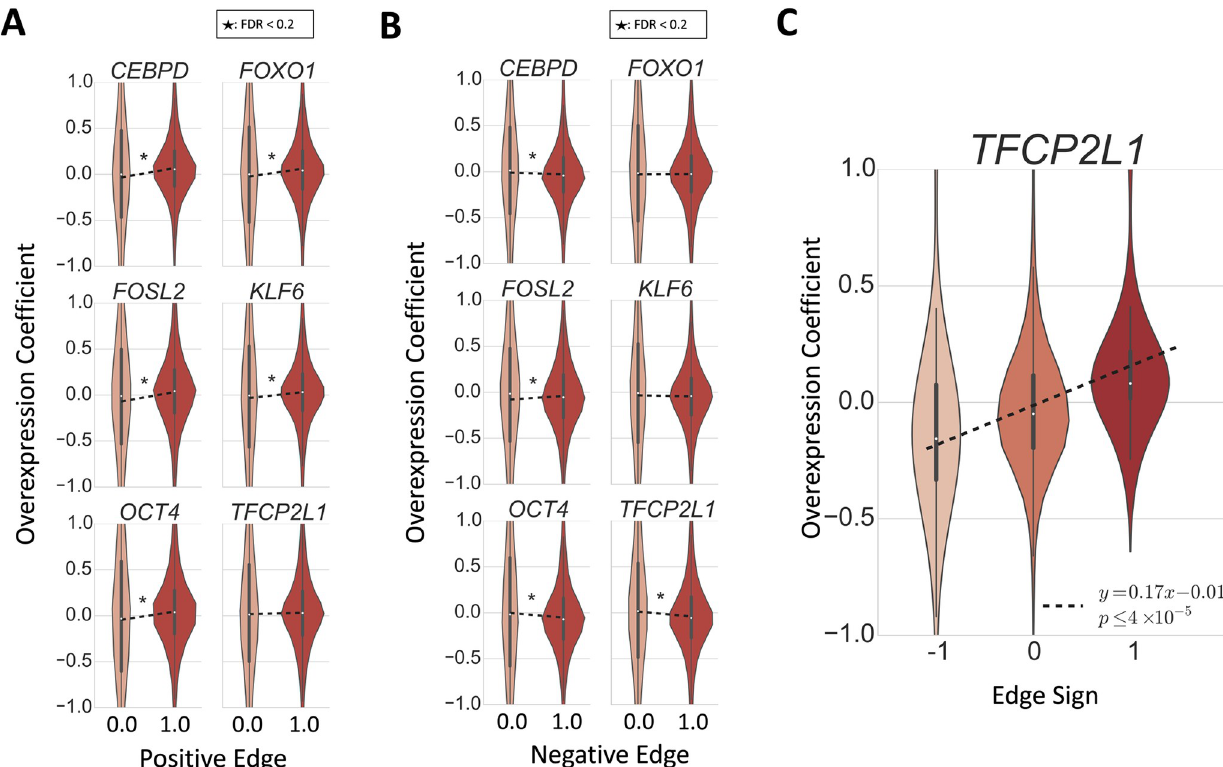
Fig 6. Validation of inferred network on overexpression data. A-B) Regression of one-hot encoding of positive (negative for B) edges as the predictor against the VAR model edge coefficient from the overexpression data as the response . A 1 indicates that an edge had a positive (in A) or negative (in B) coefficient in the original inferred network (FDR � 0.2). C) For the 123 causal edges from TFCP2L1 , regression of edge sign as the predictor against the VAR model edge coefficient from TFCP2L1 overexpression data as the response .